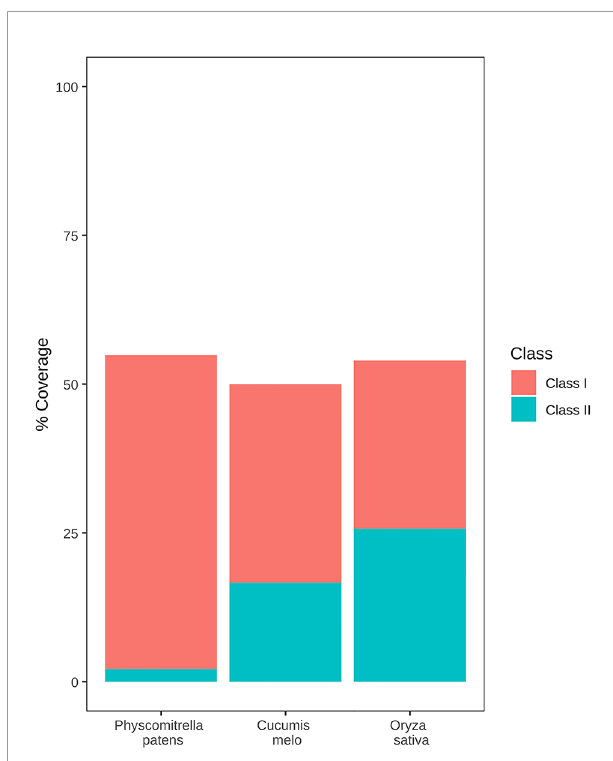
FIGURE 1 | TE content of the P. patens , rice, and melon genomes. Genome coverage of class 1 and class 2 TEs is shown as red and blue boxes